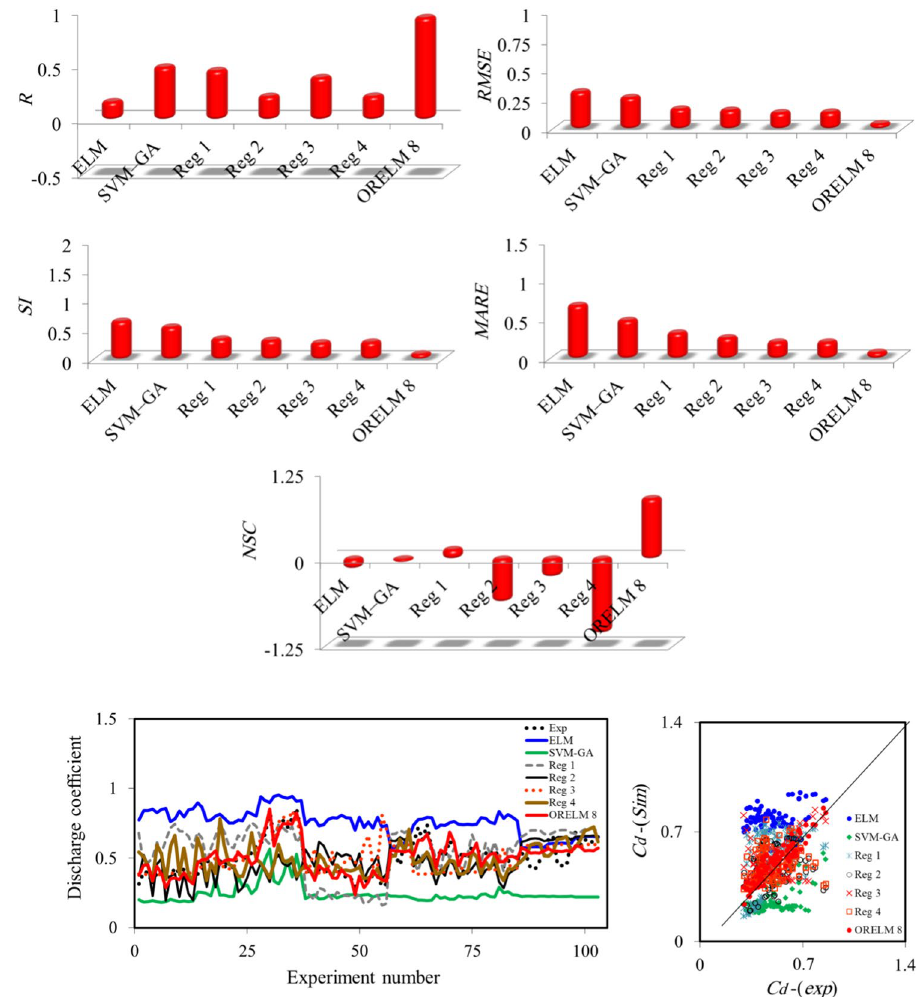
Fig. 10 Statistical indices computed for different artificial intelligence and regression models